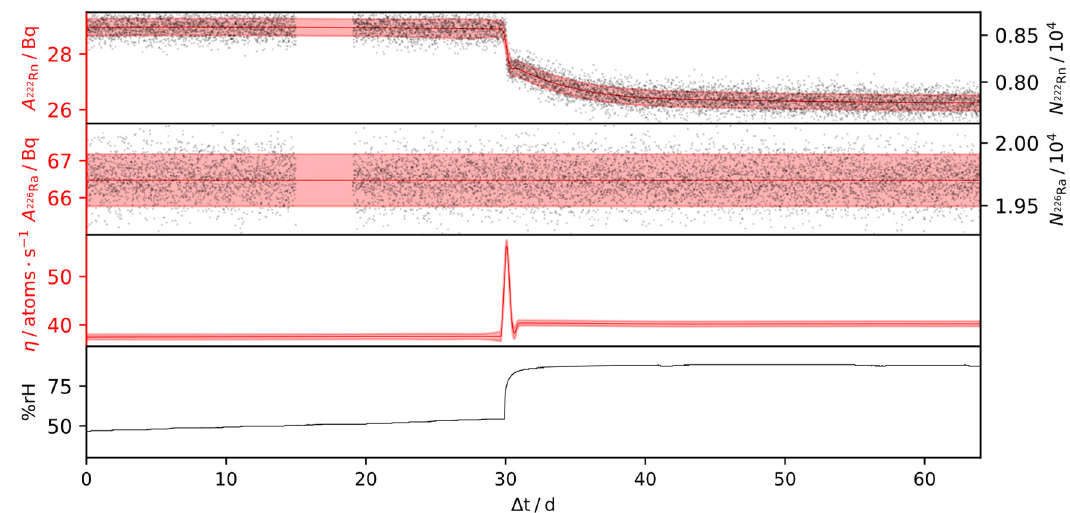
Figure 7. SLDS-deconvolution result for a IRSD of approx. 160 Bq 226 Ra. Black dots represent the determined peak areas of a set of approx. 15,000 spectra, taken over 110 days at a sampling interval of 600 s of 222 Rn and 226 Ra, respectively. Red curves represent the smoothed results for the residual 222 Rn- and 226 Ra activities and the deconvolved time-series of the emanation (cid:2015) , according to Section 2.5. Shaded areas represent the 1 (cid:2026) credible intervals, almost entirely caused by the systematic uncertainty.